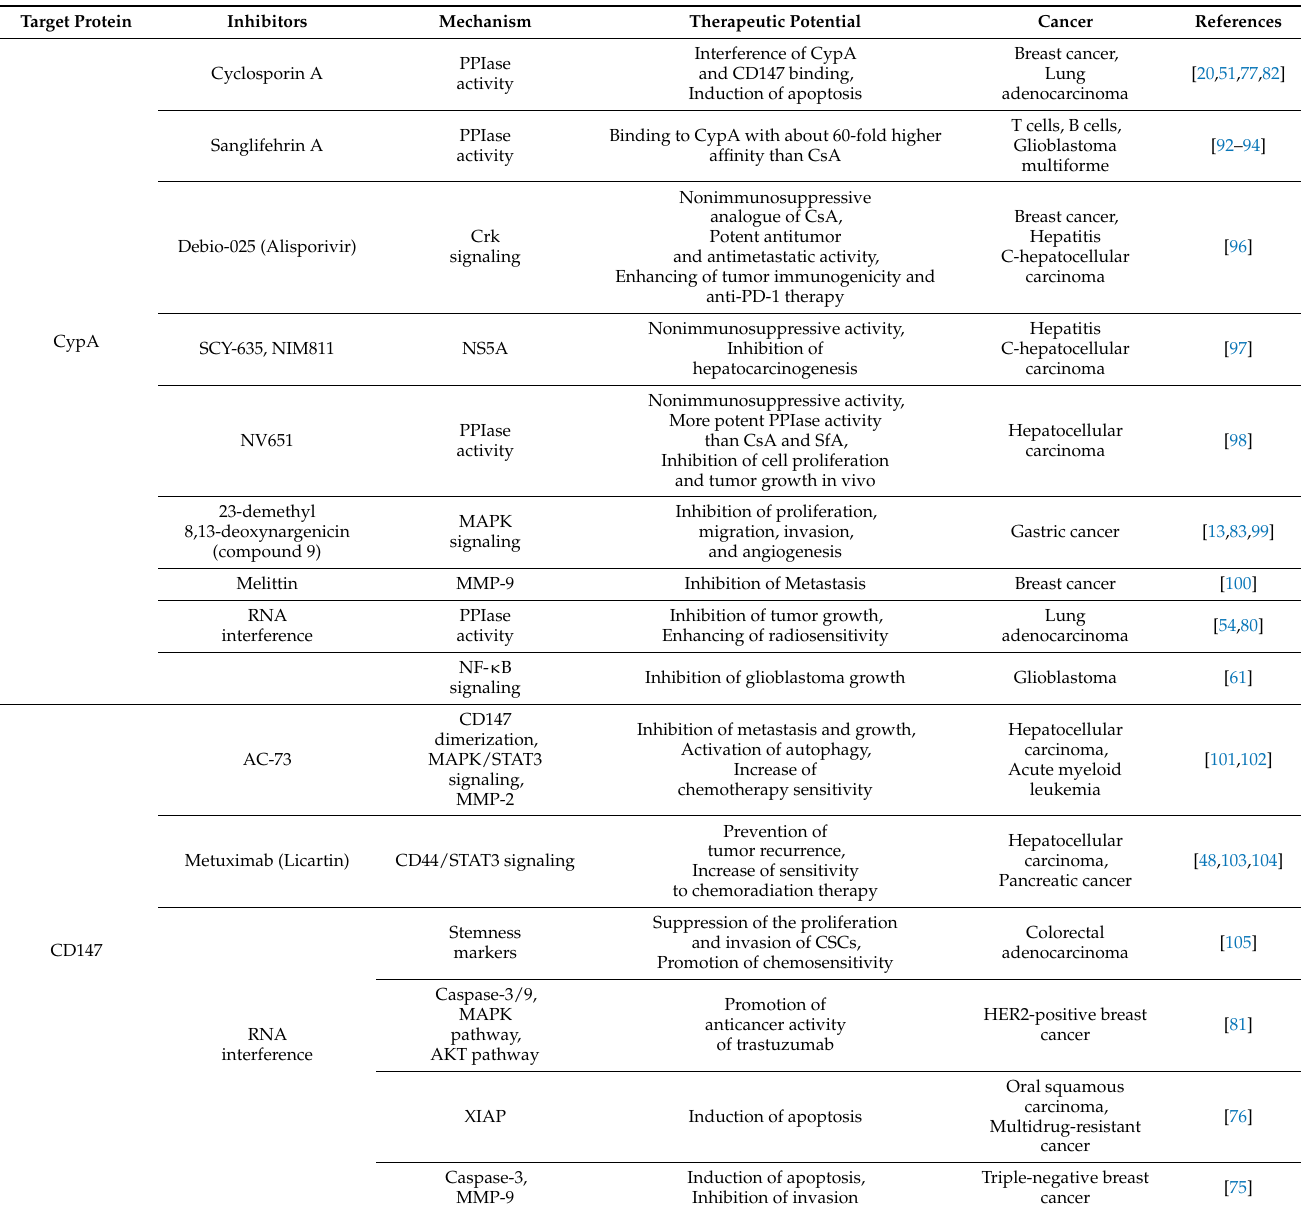
Table 2. Therapeutic potential of targeting CypA/CD147 in